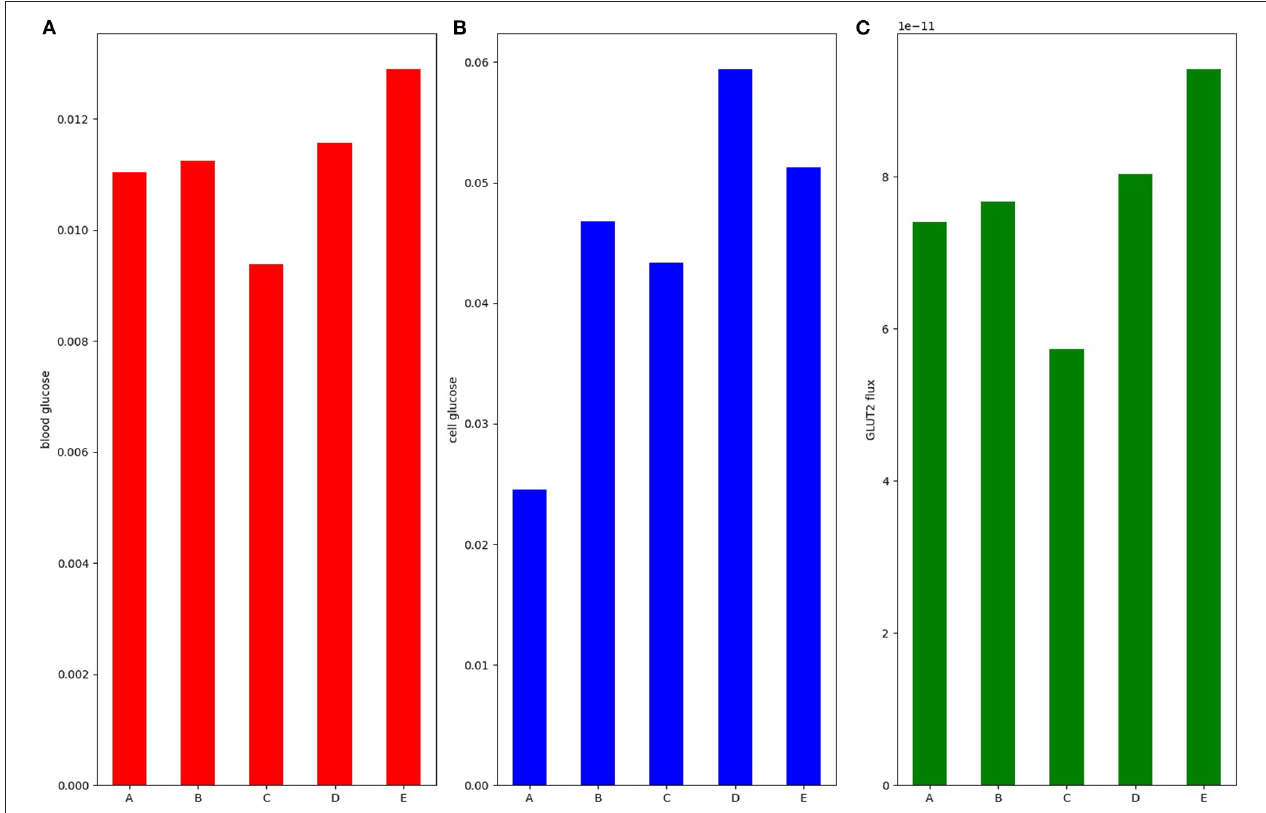
FIGURE 8 | (A) Blood glucose; (B) intracellular glucose; and (C) glucose flux into the blood. Simulation was run under 50 mM stimulus of luminal glucose. Bar A: baseline with no apical GLUT2. Bar B: 50% increase in SGLT1 and apical GLUT2 equal to 0.5 times basolateral GLUT2. Bar C: baseline SGLT1 and apical GLUT2 equal to 1.0 times basolateral GLUT2. Bar D: 100% increase in SGLT1 and apical GLUT2 equal to 0.5 times basolateral GLUT2. Bar E: 100% increase in SGLT1 alone with no apical